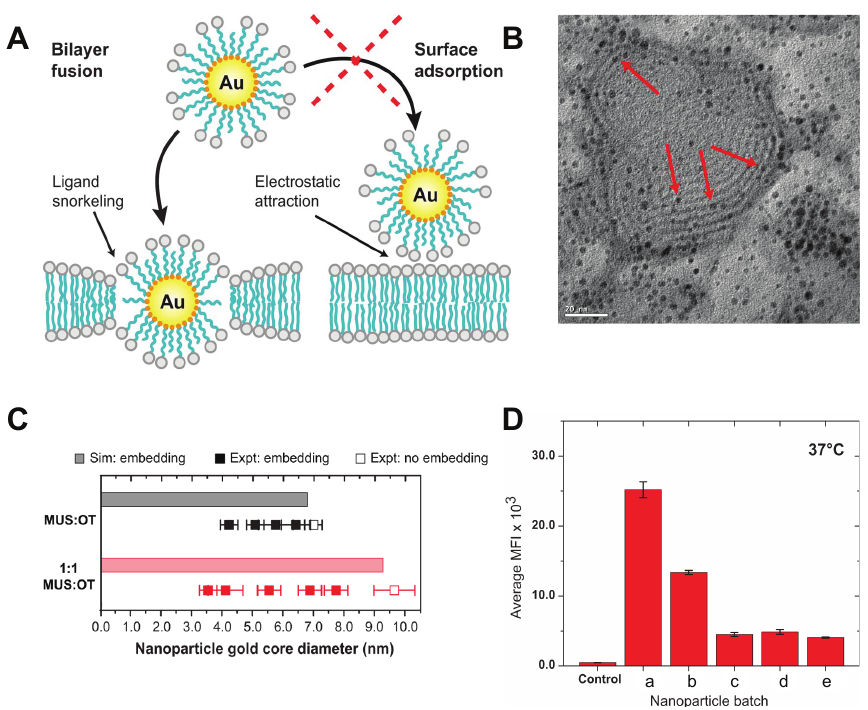
Figure 2. Penetration of the amphiphilic polymer decorated NPs and its dependence on NP diameter and surface composition. ( A ) Schematic description of the interaction between amphiphilic polymer-decorated NPs and the cell membrane; ( B ) Transmission electron microscopy (TEM) image of the giant multilayer vesicle interacting with 1:1 MUS:OT NPs. The red arrows point out that the Au NPs were inserted into the lipid bilayer. The average diameter of the NPs is 2.2 nm; ( C ) Filled-in squares represent experimental particles that successfully inserted, while empty squares specify those that did not; ( D ) HeLa cellular uptake in 37 ◦ C for all MUS NPs with different diameters, a (2.4 ± 0.2 nm), b (2.9 ± 0.5 nm), c (3.4 ± 0.8 nm), d (4.9 ± 1.1 nm), e (5.8 ± 1.4 nm). The cellular uptake was measured by the median fluorescence intensity. The figures are adapted from References [52,54] with